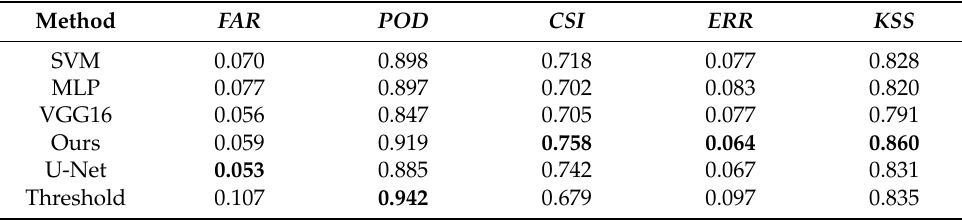
Table 3. A comparison of the experimental evaluation metrics of different